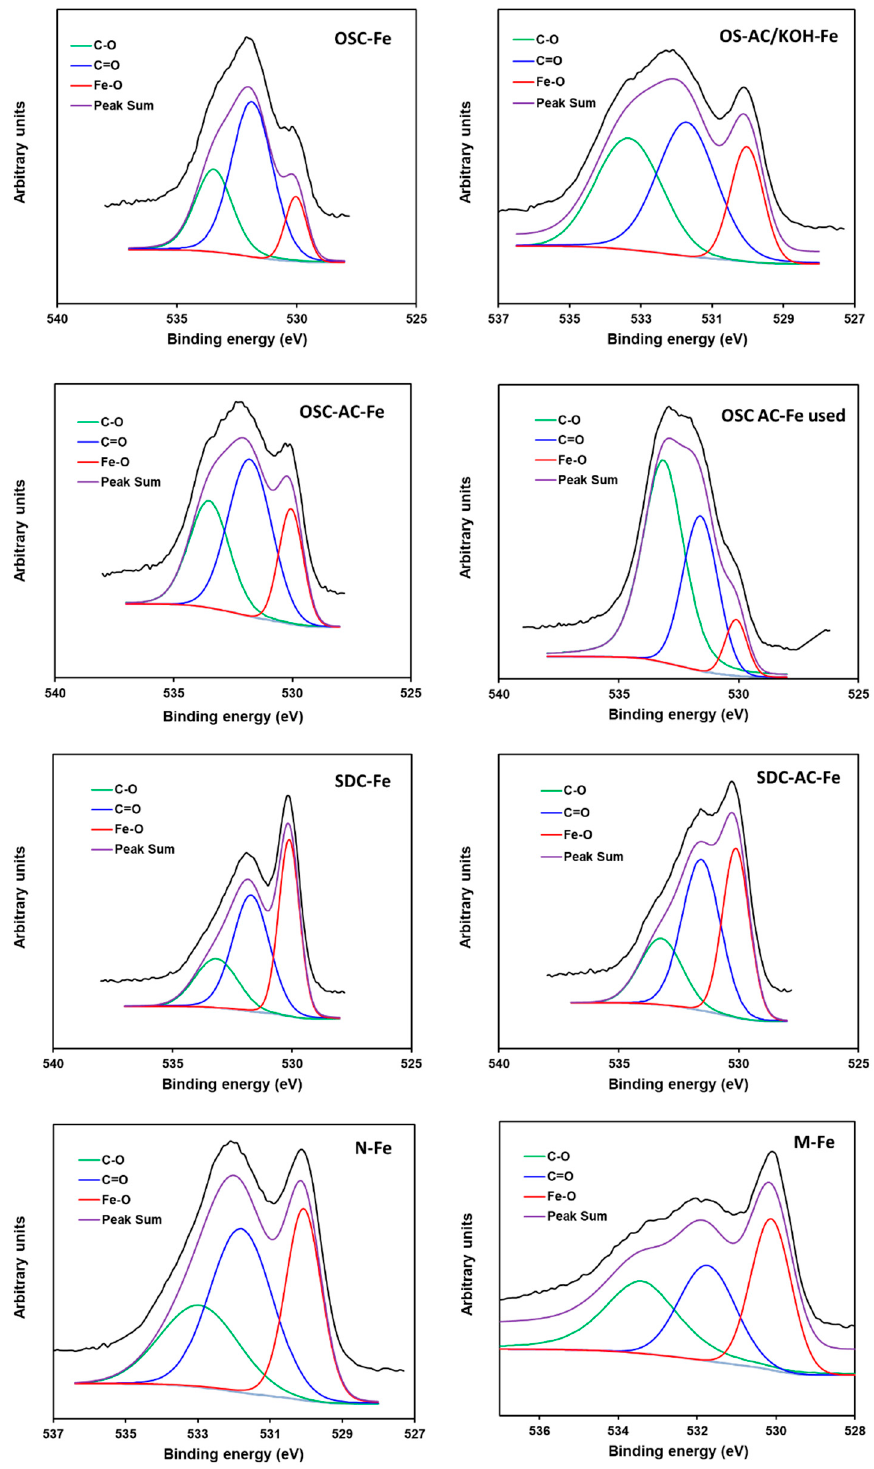
Figure 8. O1s XPS spectral region of the different catalysts.